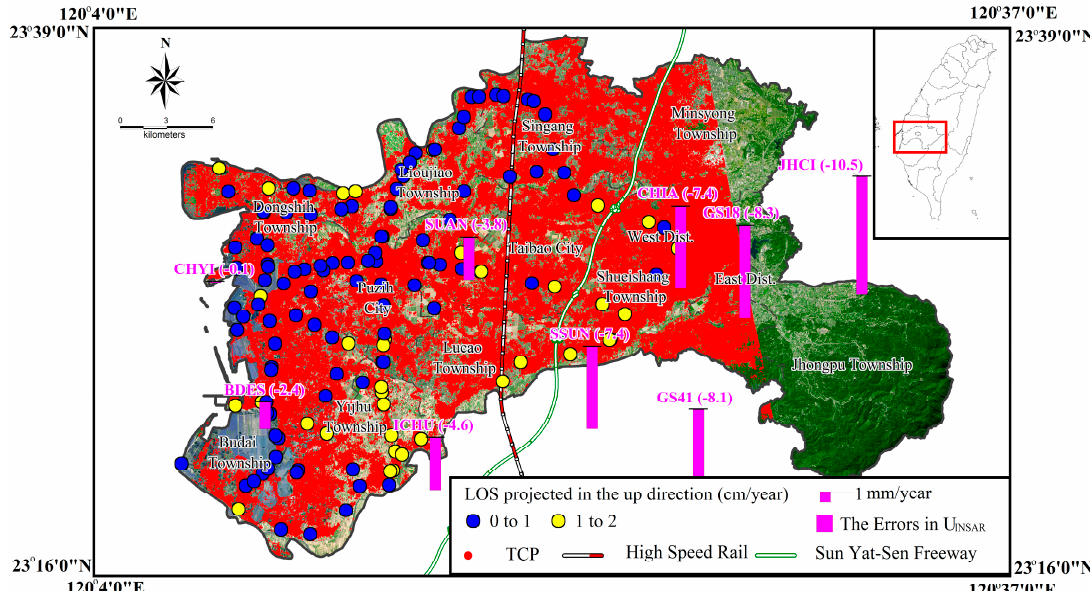
Figure 9. Distributions of TCPs (red dots) and leveling benchmarks (blue, solid circles) in Chiayi, and the differences between the vertical displacement rates derived from InSAR (from LOS projections) and leveling (explained in Figure 14). The vertical bars show errors in the vertical displacement from InSAR caused by neglecting horizontal motions at GPS stations (Figure 1a).